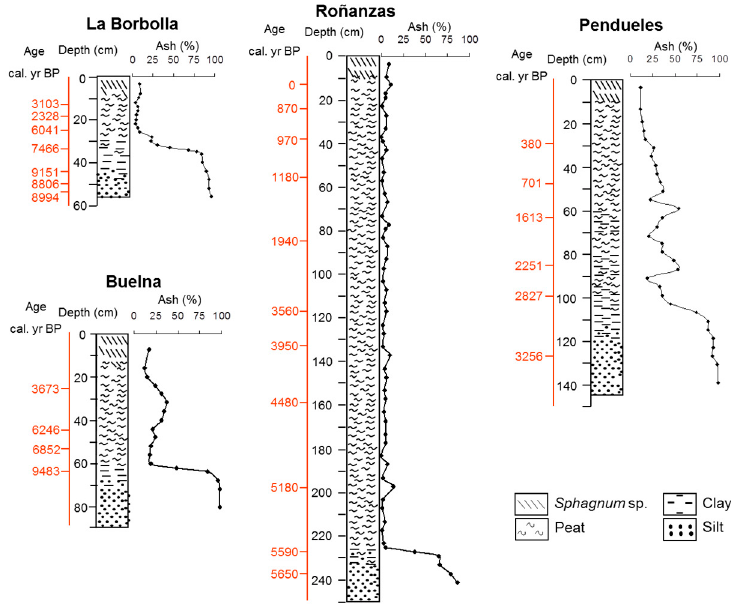
Figure 2. Lithology of the peat profiles with indications of depth and age and the ash content.